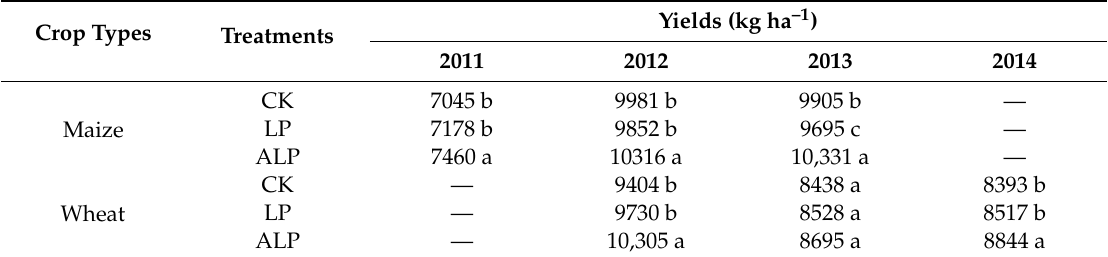
Table 7. Crop yields at harvest time in 2011 − 2014 growing seasons [8].